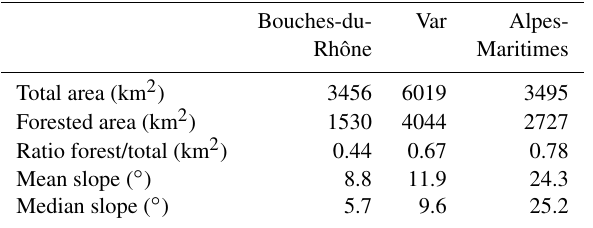
Table 1. Environmental characteristics of the study area per admin- istrative division